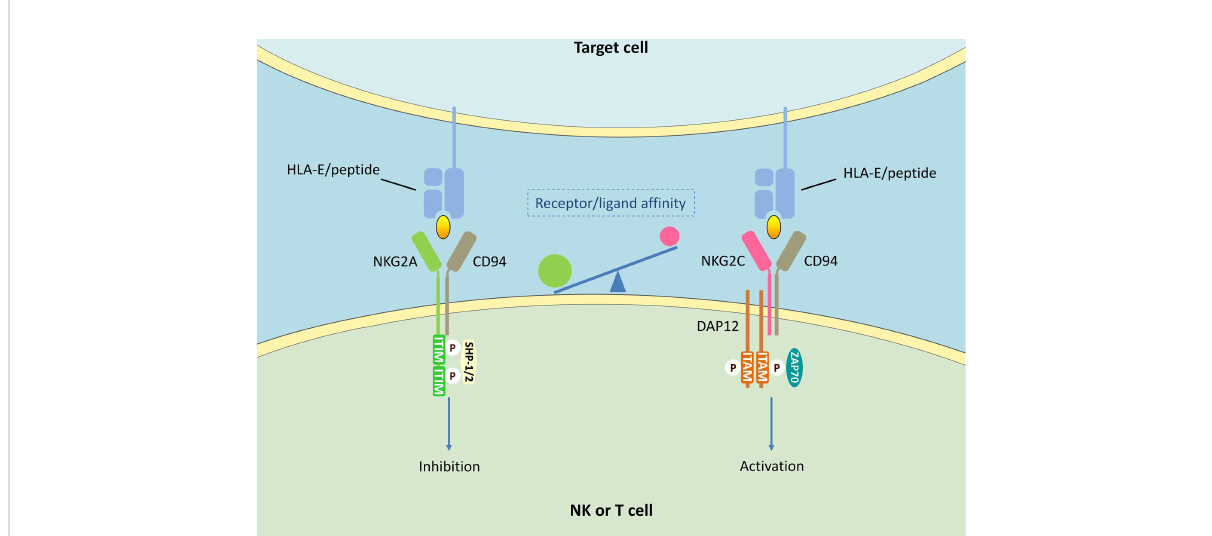
FIGURE 1 NKG2A/CD94 and NKG2C/CD94 signalings in NK cells and T cells. HLA-E can bind to both NKG2A/CD94 and NKG2C/CD94 receptors. The interaction of NKG2A/CD94 receptor with peptide-presenting HLAE results in the phosphorylation of ITIMs. Phosphorylated ITIMs are responsible for recruiting and activating intracellular phosphatase SHP-1/2, thus delivering negative signals. CD94/NKG2C heterodimers associates with DAP12 containing immune receptor tyrosine activating motifs (ITAMs), thus activating zeta-chain-associated protein kinase 70 kDa (ZAP70) and delivering activating